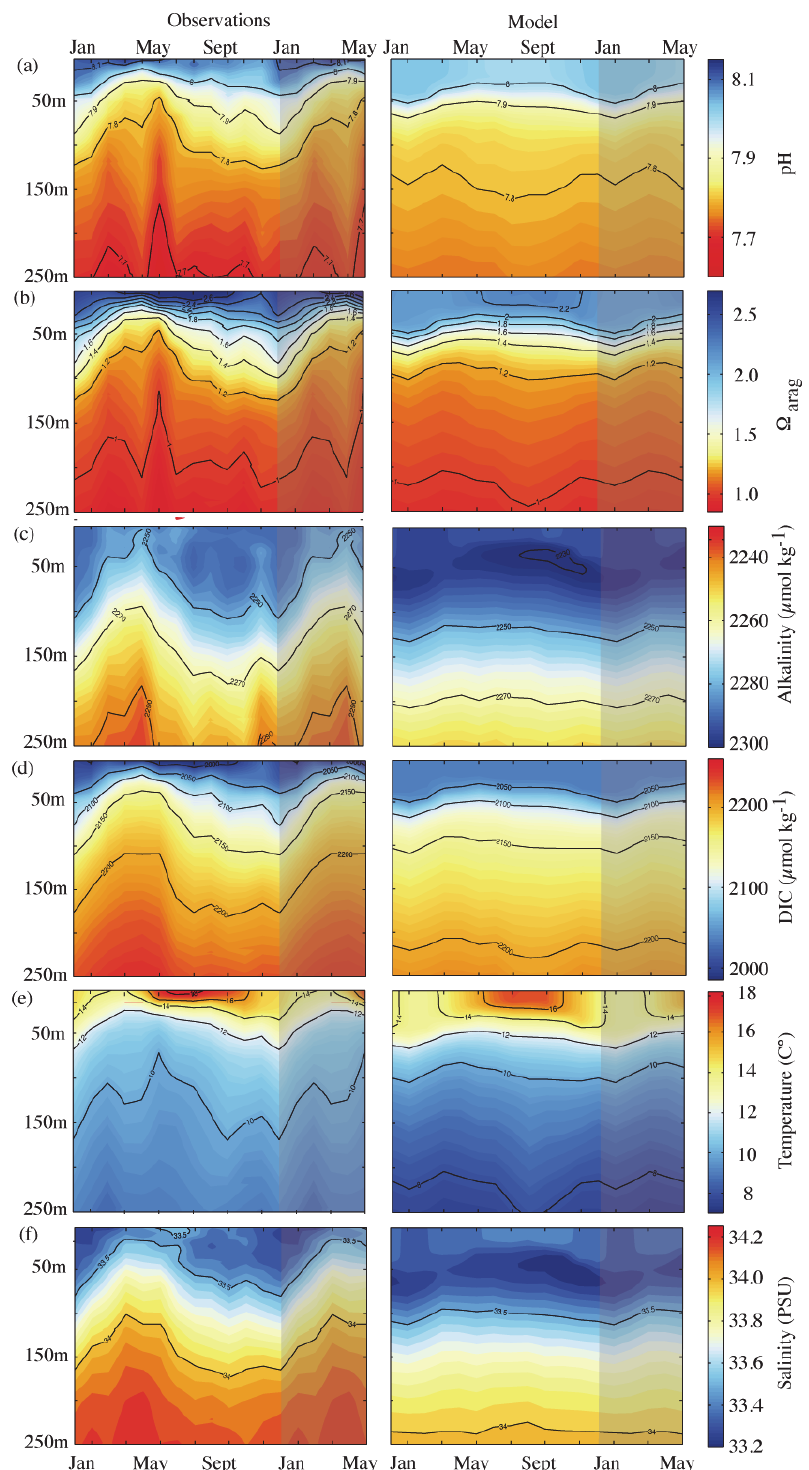
Fig. 6. Comparison of bi-weekly observed (2003–2008; Santa Monica Bay Observatory Mooring) and model simulated climatologies of (a) (cid:127) arag , (b) pH, (c) alkalinity, (d) DIC, (e) temperature and (f) salinity at 0–250m between 2005 and 2010. The shaded area depicts the first six months of the following annual cycle.